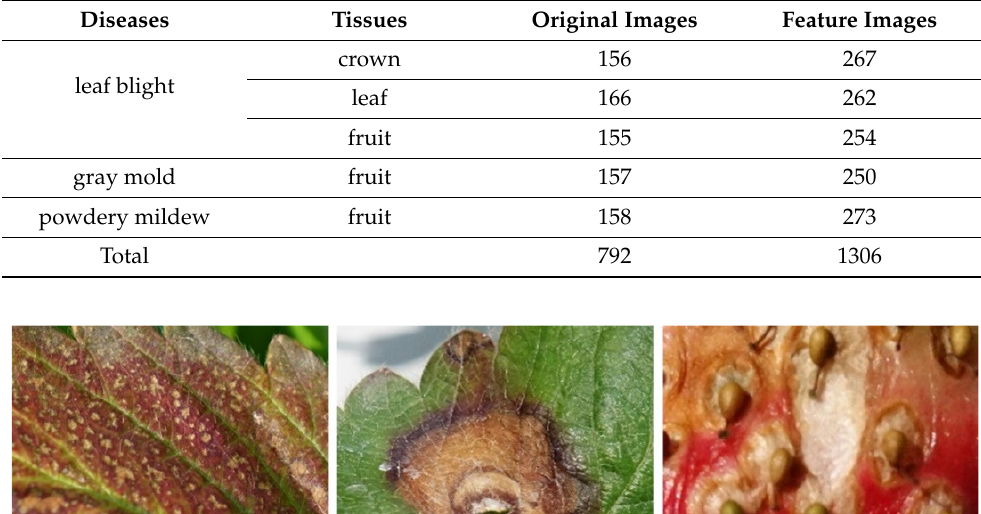
Table 1. Table of numbers of disease images from original and feature data sets.